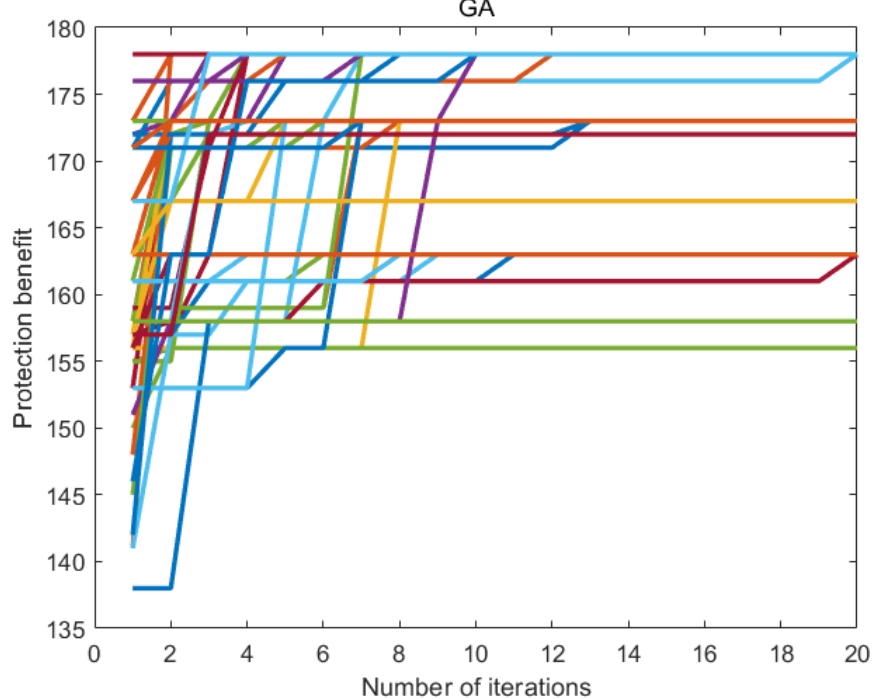
Figure 6. Population size is 15, and the GA algorithm is run 100